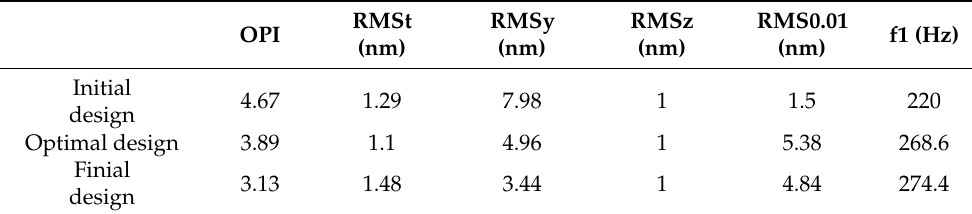
Table 4. Comparison of results between the initial, optimal and final